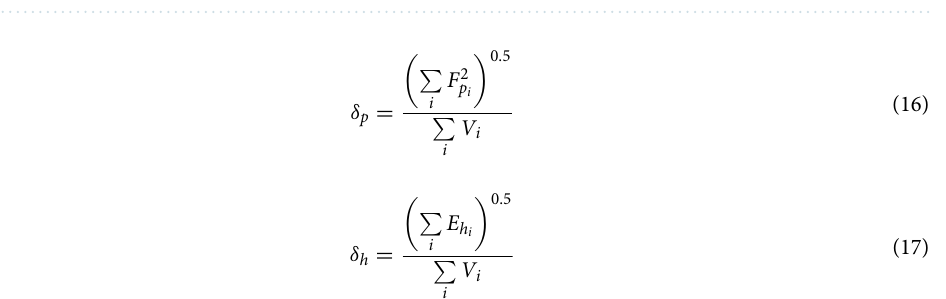
Figure 2. Experimental binodal curves determined for the ATPSs composed of different copolymer + salt at 298